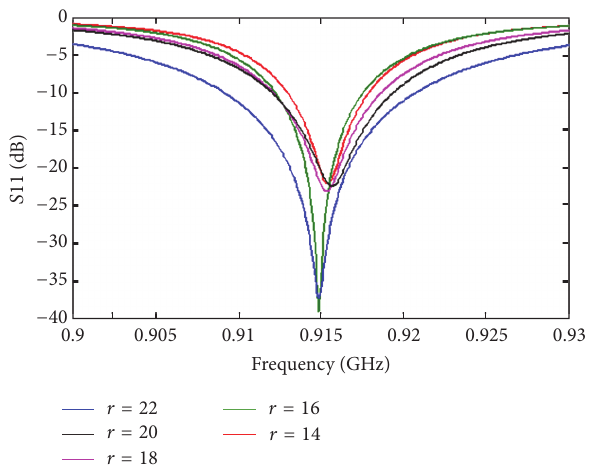
Figure 15: Return loss 𝑆11 of each 3D spherical antenna (Table 6).